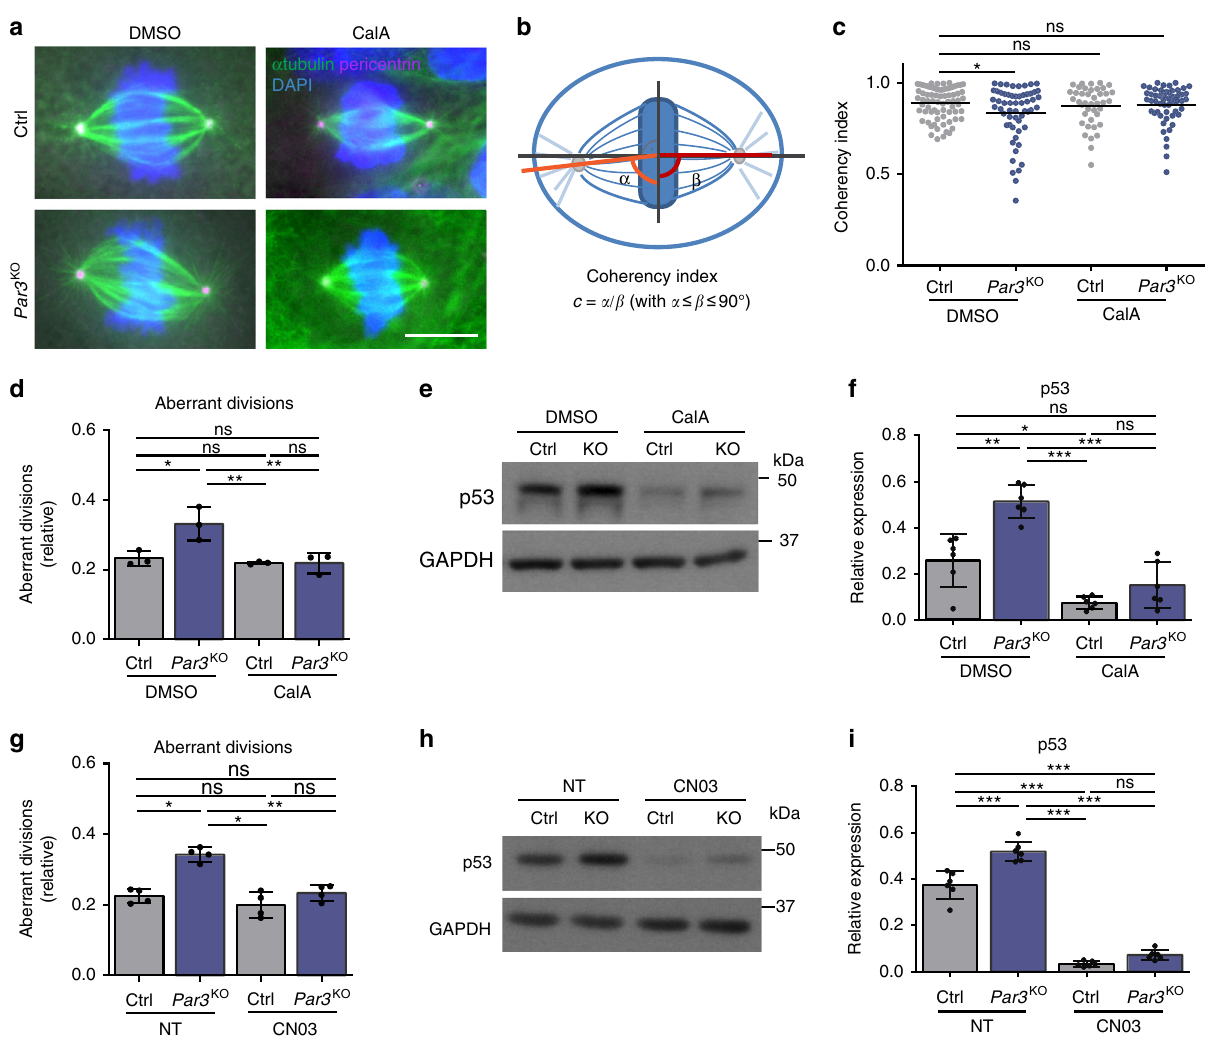
Fig. 6 Restoration of Rho activity or actomyosin contractility rescues mitotic fi delity and p53 stabilization in Par3 KO cells. a Immuno fl uorescence micrographs of mitotic keratinocytes stained for pericentrin (green) and alpha-tubulin (magenta), scale bar: 10 µ m. Intensity was enhanced for better spindle visualization. b Schematic representation of analysis for mitotic spindle geometry. c Quanti fi cation of coherency index (Ctrl/DMSO-treated: n = 73 cells, Par3 KO/DMSO-treated: n = 58 cells; Ctrl/CalA-treated: n = 41 cells, Par3 KO/CalA-treated: n = 55 cells; in all cases pooled from four independent experiments), * p = 0.0207, bar represents mean, one-way ANOVA/Dunnett ’ s multiple comparisons test. d Quanti fi cation of aberrant cell divisions in primary Par3 KO and control keratinocytes observed in time-lapse microscopy upon DMSO and CalA (1 nM) treatment (relative values). n = 3 independent experiments, mean ± SD, * p = 0.0154 (Ctrl/DMSO vs. Par3 KO/DMSO), ** p = 0.0078 ( Par3 KO/DMSO vs. Ctrl/CalA), ** p = 0.0076 ( Par3 KO/DMSO vs. Par3 KO/CalA) one-way ANOVA/Tukey ’ s comparison test. e Immunoblot analysis of p53 upon DMSO and CalA (1 nM) treatment. GAPDH served as loading control. f Quanti fi cation of e . p53 levels were fi rst normalized to GAPDH and then expressed as relative values. n = 6 biological